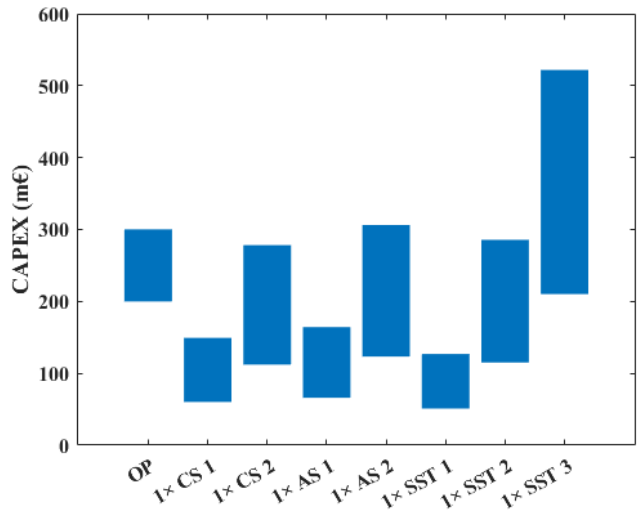
Figure 9. CAPEX Figure 9. CAPEX estimations.